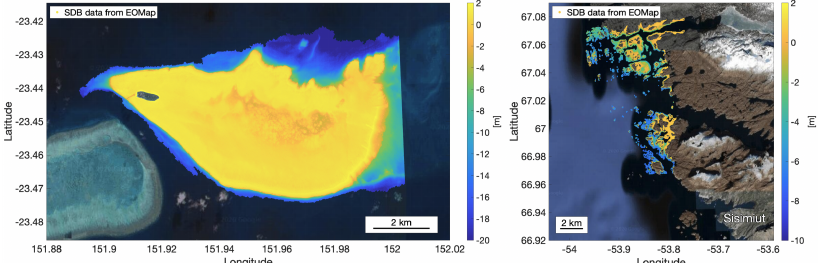
Figure 1. ( left ) SDB bathymetry of Heron Reef wrt. to the mean sea level, and ( right ) north of Sisimiut, Greenland, wrt. the